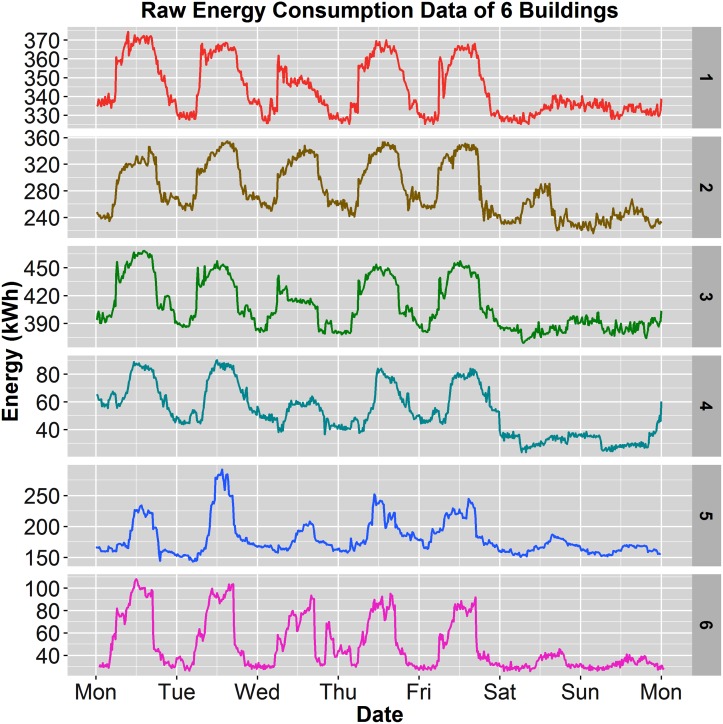
Week view of electricity consumption.Electricity consumption of one week for all 6 buildings. Building number label is to the right of each plot.